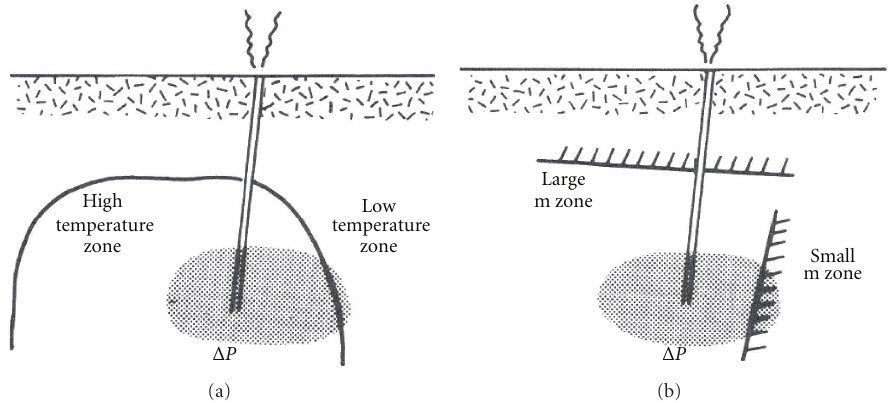
Figure 8: Models for production-induced SP change, after [145]. (a) High-low temperature interface, or (b) large-small pore hydraulic radius (m) interface acts as a boundary between regions of di ff ering streaming potential coe ffi cient. Shaded region: zone of production- induced pressure